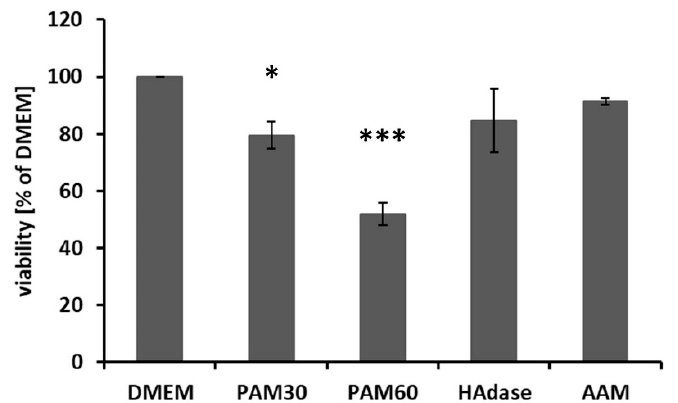
Figure 5. Cell viability of HaCaT cells after cultivation in the different PAM or control media for 48 h. The cell viability was decreased in PAM depending on the treatment time used for generation of PAM (mean ± s.e.m., n = 3, unpaired t -test, * p < 0.05, *** p < 0.001). Abbr.: DMEM: Dulbecco’s modified Eagle’s medium, PAM30: 30 s plasma-treated DMEM, PAM60: 60 s plasma-treated DMEM, AAM: 60 s argon gas-treated DMEM, HAdase: DMEM with hyaluronidase.